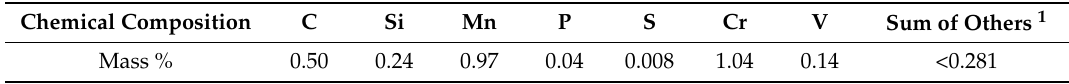
Table 2. Chemical composition of DIN 51CrV4 steel